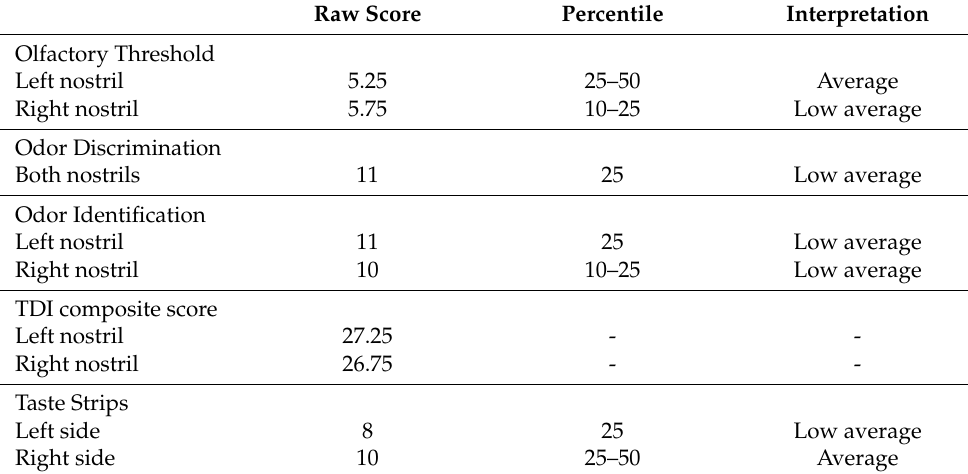
Table 1. Results obtained by our patient on olfactory and gustatory